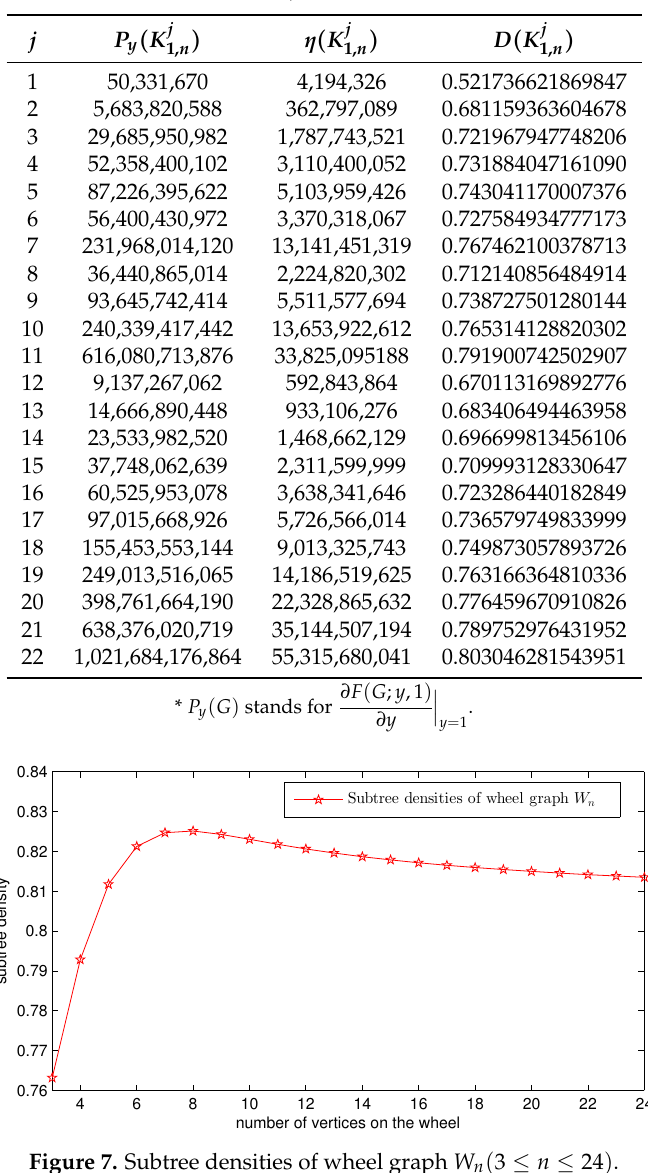
, with n = 22 and j = 1,2, . . . ,22. 1, n